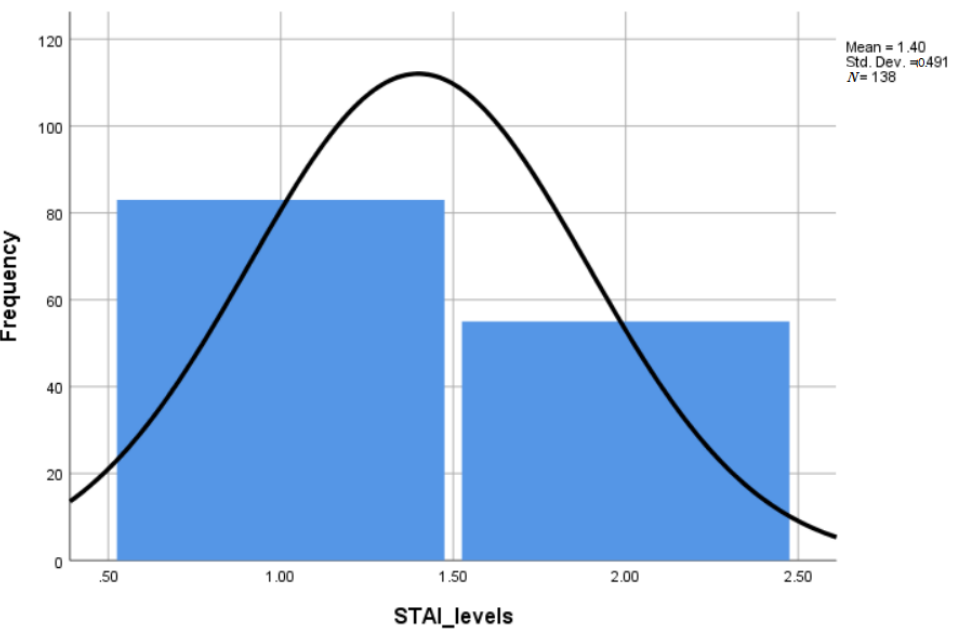
Figure 2. The post-scan anxiety scores.